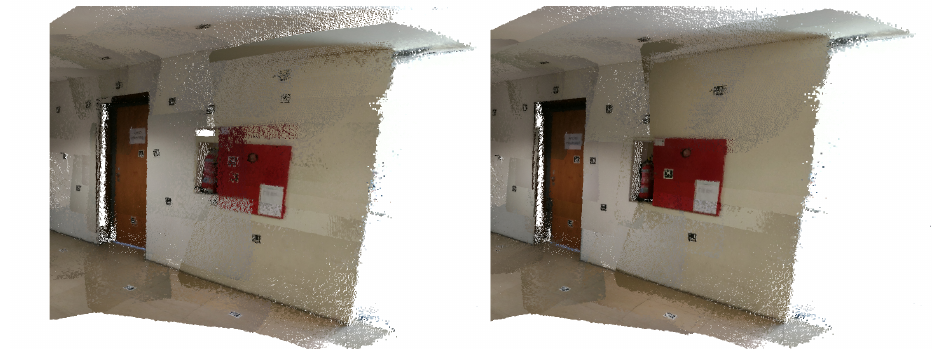
Figure 26. Lobby dataset coloured with texture obtained from original images (detail): ( left ) Google Tango; ( right ) Our